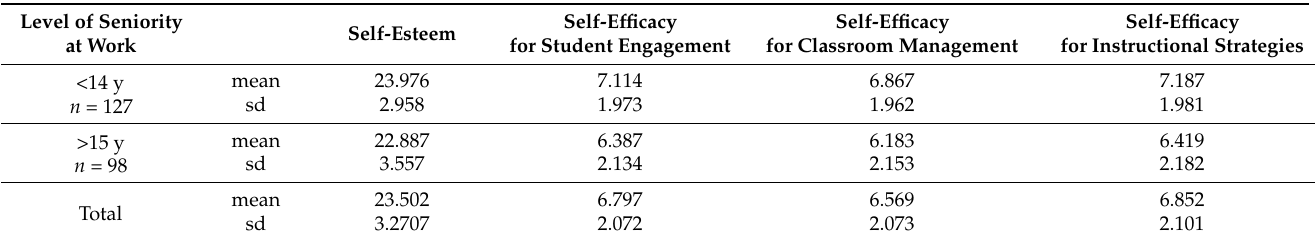
Table 5. Means and standard deviations regarding the levels of